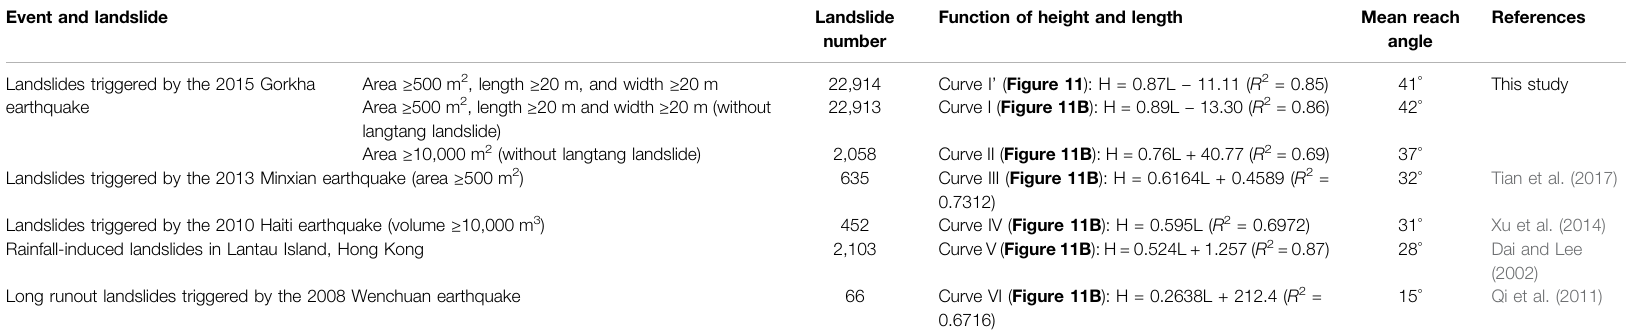
TABLE 3 | Fitting relationships of landslide height and length for fi ve study